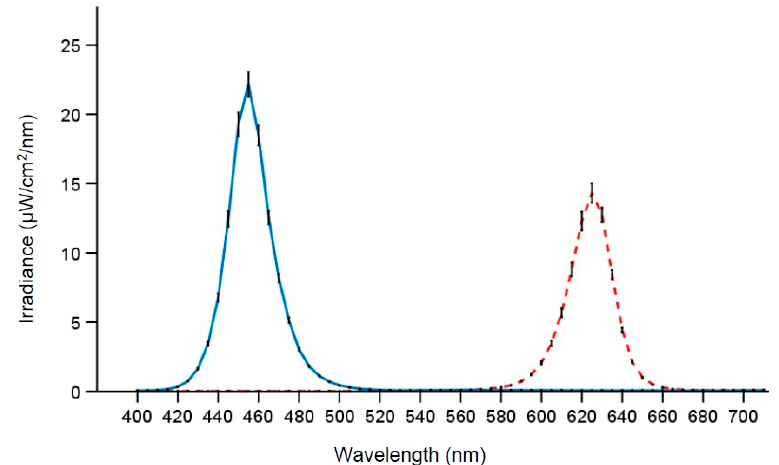
Figure 2. Spectral distribution of the short-wavelength narrow-bandwidth light (solid line) and the long-wavelength narrow-bandwidth light (dotted line). Means and SD (error bars) for measurements (vertical plane) at eye level.